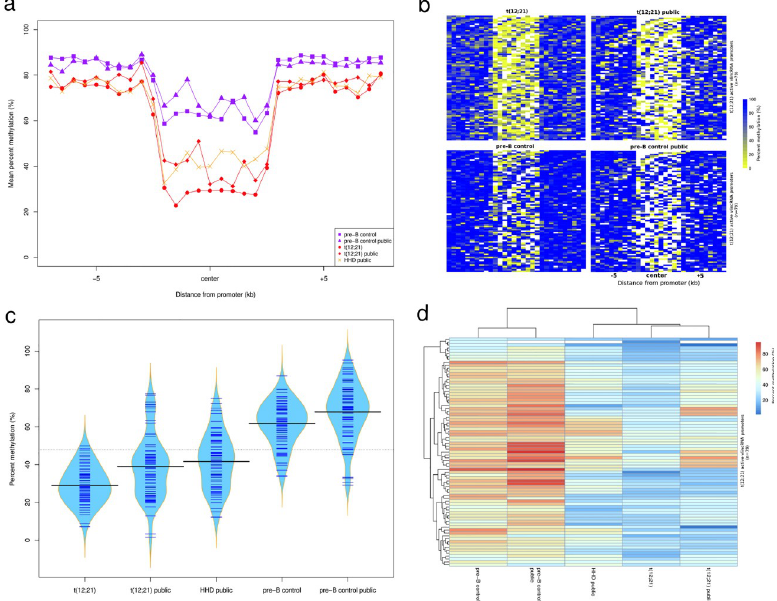
Fig 5. Methylation regulation of t(12;21) active vlincRNA promoters. (a) WGBS mean methylation levels of t(12;21) active promoters (n = 79) in t(12;21), HHD and pre-B control CD10 + CD19 + datasets from this study and public data [11]. Each data point represents 10% of promoter size and flanking regions size ( ± 10kb). (b) WGBS methylation heatmap of t(12;21) active promoters in t(12;21) and pre-B control CD10 + CD19 + datasets from this study and public data (white = no covered CpGs). Each column represents 10% of promoter size and flanking regions size ( ± 10kb). (c) DNA methylation beanplot of t(12;21) active promoters in t(12;21), HHD and pre-B control CD10 + CD19 + datasets from this study and public data. (d) Hierarchical clustering of methylation levels of t(12;21) active promoters in t (12;21), HHD and pre-B control CD10 + CD19 + datasets showing similar methylation profiles between this study and public